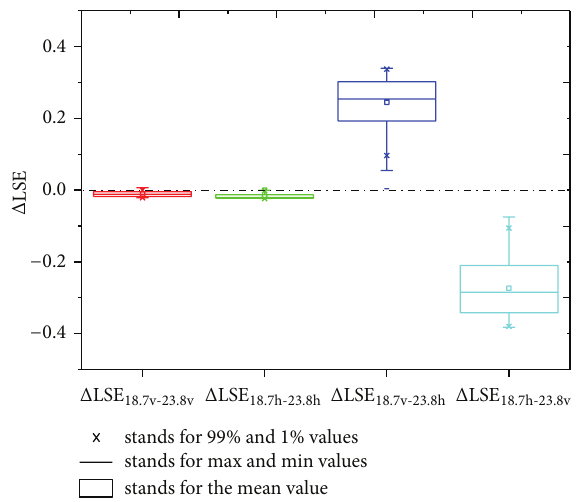
Figure 2: Box charts of four LSE polarization differences: Δ LSE Δ LSE Δ LSE Δ LSE 18.7 v - 23.8 v , 18.7 h - 23.8 h , 18.7 v - 23.8 h , and 18.7 h - 23.8 v .